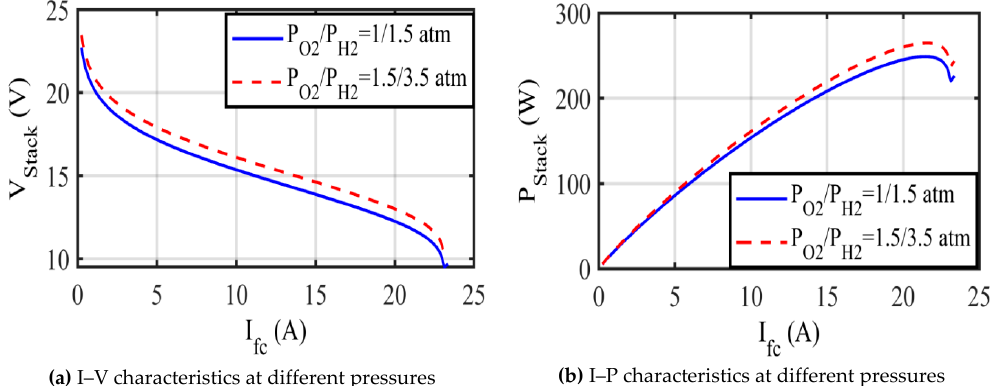
Figure 10. Characteristics of the 250 W stack at different pressures.